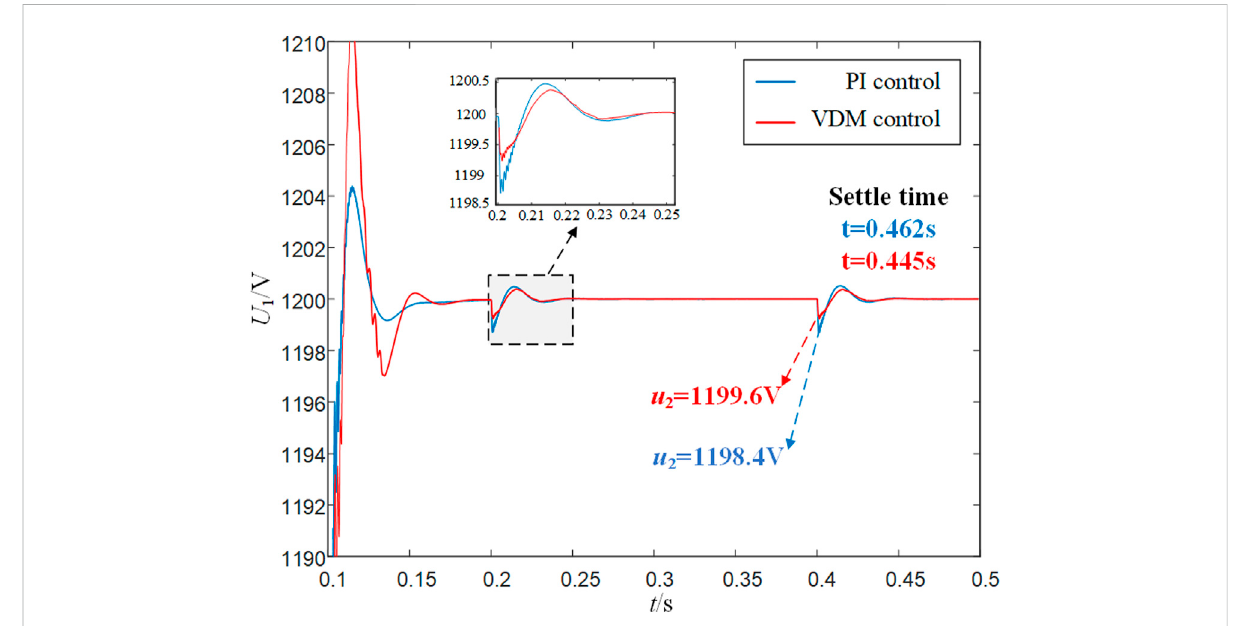
FIGURE 13 Comparison diagram of DC bus voltage under CPL load linear change